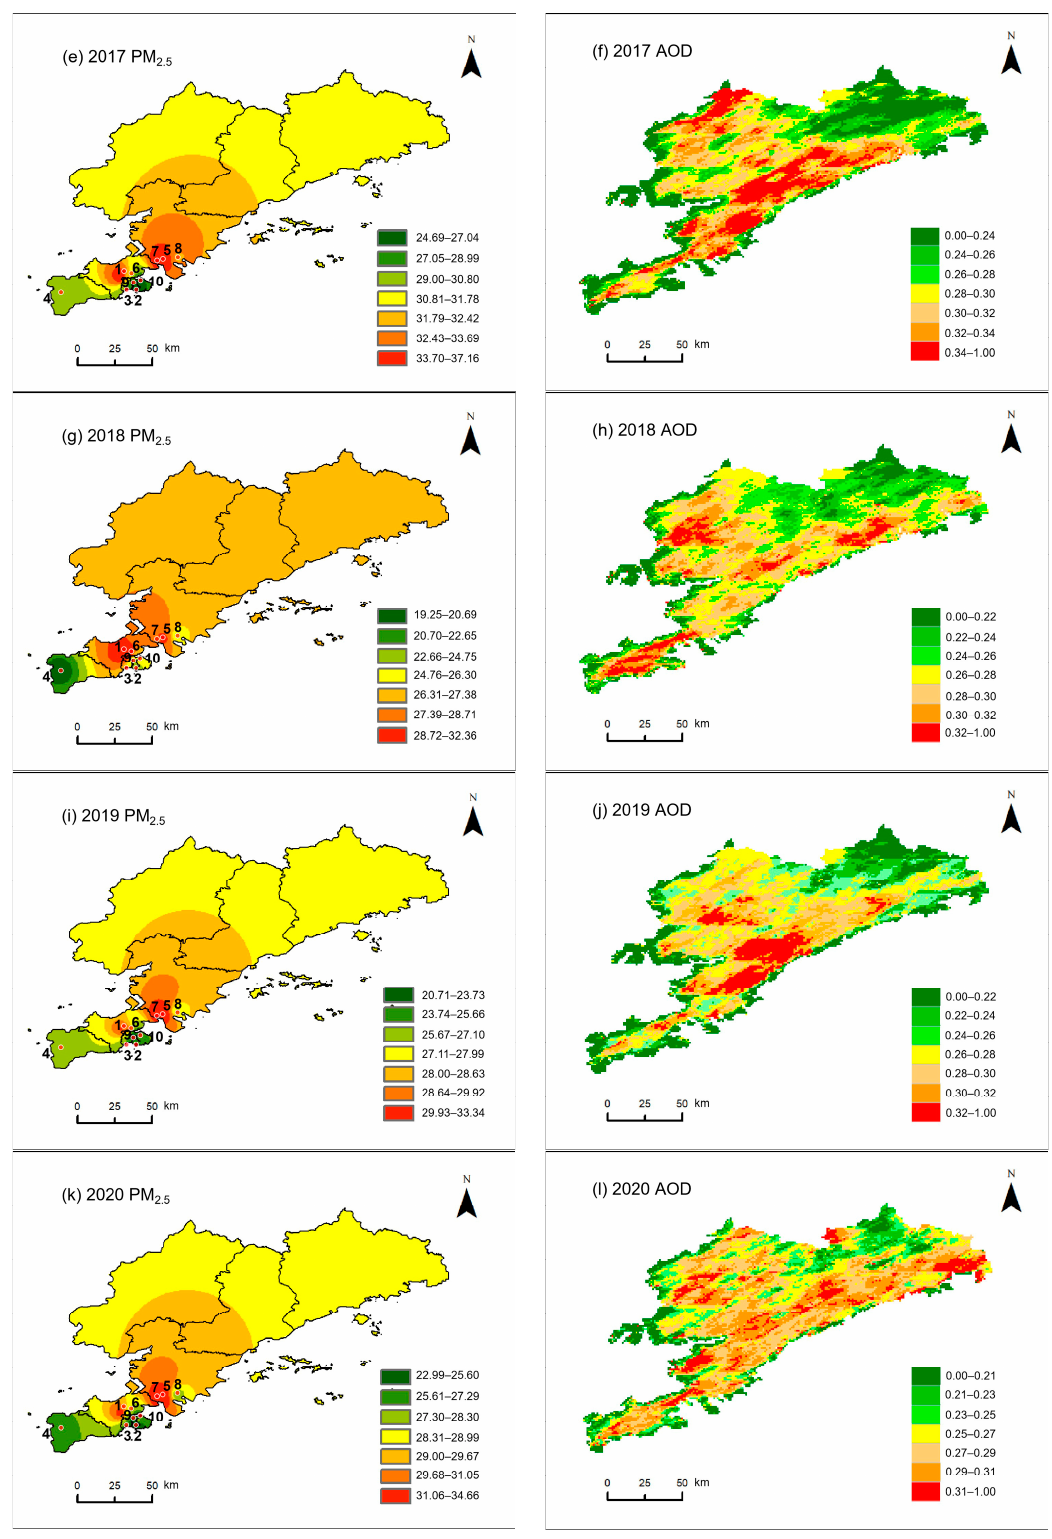
Figure 6. Temporal spatial distribution of PM 2.5 and AOD from 2015 to 2020. The AOD overall spatial distribution of the remote sensing can be obtained from Fig- ure 6. The AOD value in the northeastern part of Dalian is relatively low, while the AOD value in the northwestern part and the eastern coastal area is relatively high. The distri- bution curve of Dalian’s population density (https://www.worldpop.org/, accessed on 10 January 2022) in 2020 and the spatial structure of Dalian are shown in Figure 7. PM2.5 and AOD had high values in areas with a high population density, and low values in Zhuanghe City, North Dalian, where the population density was relatively low. Jinzhou District and Pulandian District in central Dalian had a moderate population density, and